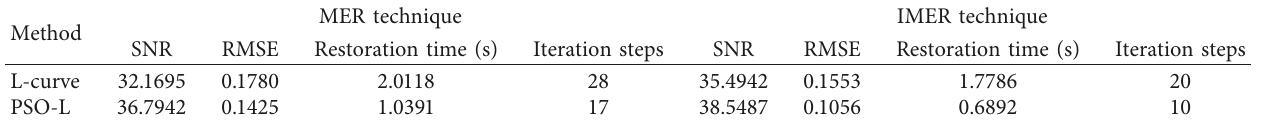
Table 3: The measurement metrics comparisons using method